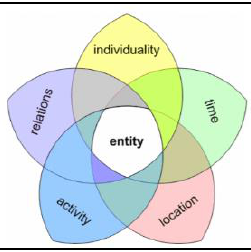
Figure 3 . The five basic categories for context information (Zimmermann et al.,